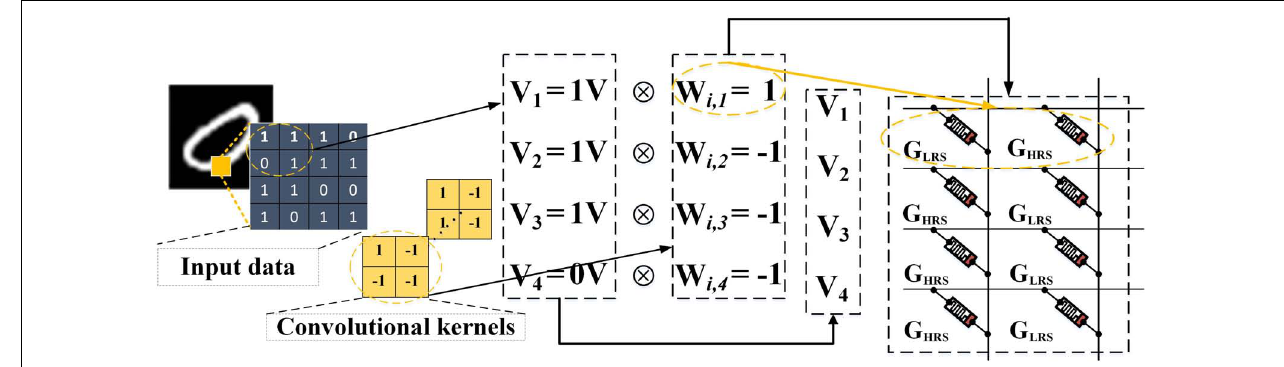
FIGURE 4 | The demo about how to execute a convolution operator by using memristor crossbar. The size of the convolutional kernel is 2 × 2. The inputs sent to the array are in the form of DC voltage, and each weight is stored by two